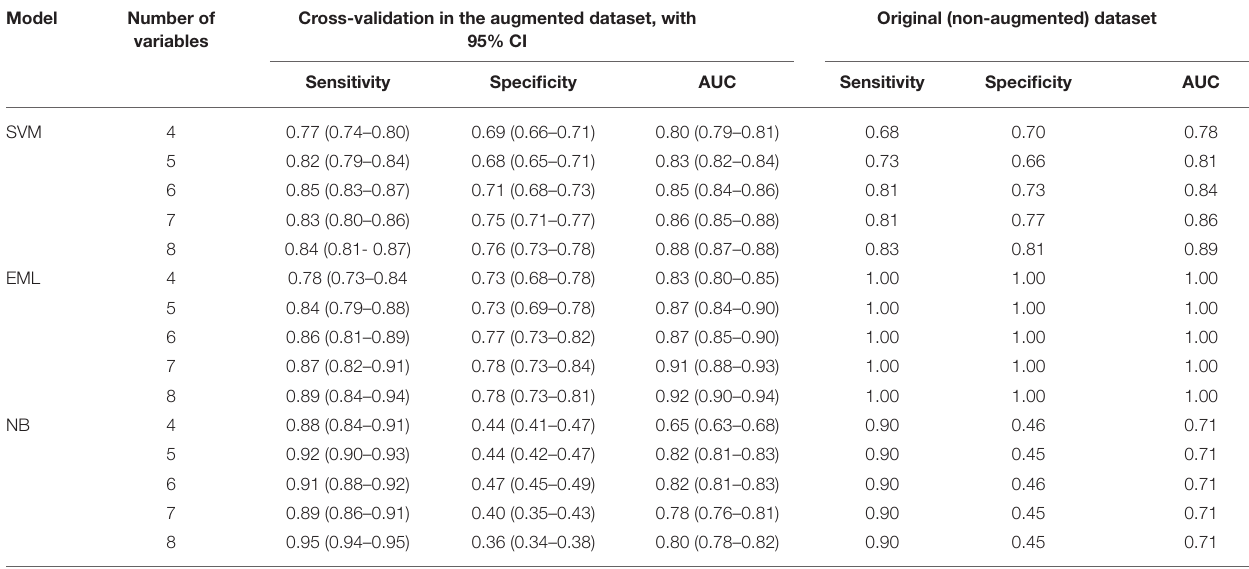
TABLE 3 | Performances of different models as a function of increasing number of variables allowed.